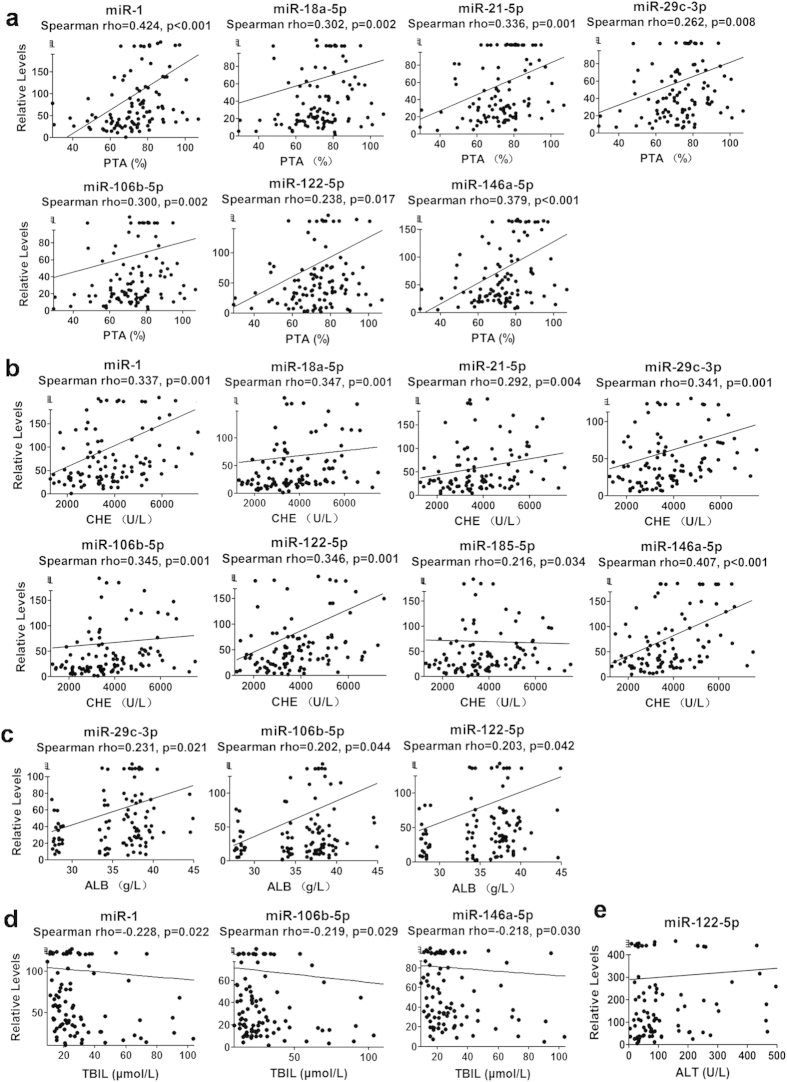
Correlations of miRNAs expression and liver function in patients of validation phase.Correlations of miRNAs expression and PTA (a), CHE (b), ALB (c) and TBIL(d) levels in LC patients, and correlation of miRNA expression and ALT (e) levels in CHB patients. Y axis represents relative expression levels of each miRNA in the corresponding subjects. P values were calculated using the Mann-Whitney test and p < 0.05 was significant.